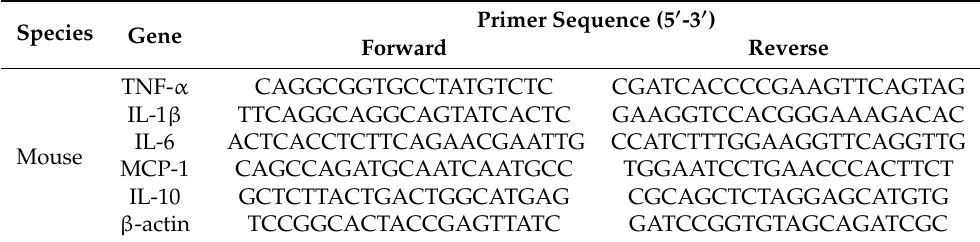
Table 1. Primer sequences for quantitative reverse transcription polymerase chain reaction